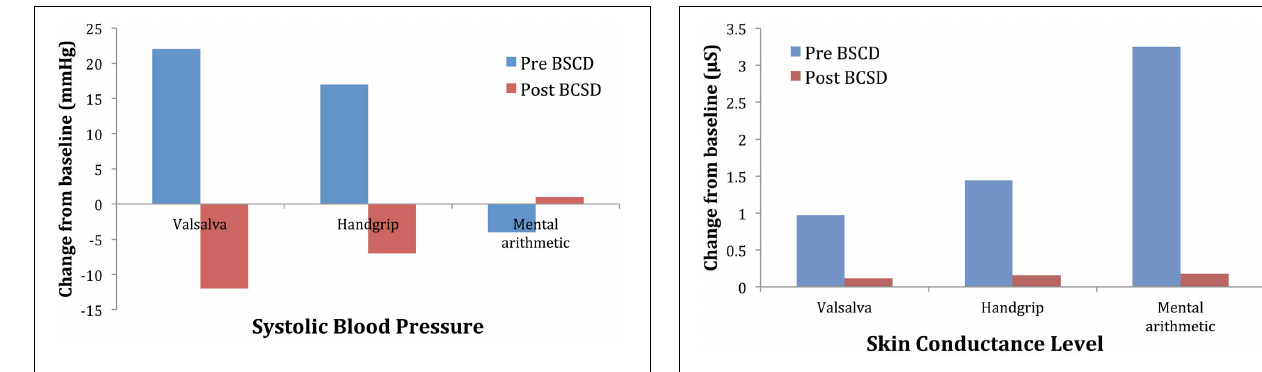
FIGURE 7 | Mean changes in skin conductance level from baseline during autonomic challenge before and after bilateral cardiac sympathetic decentralization (BSCD) in case 2. µ S,